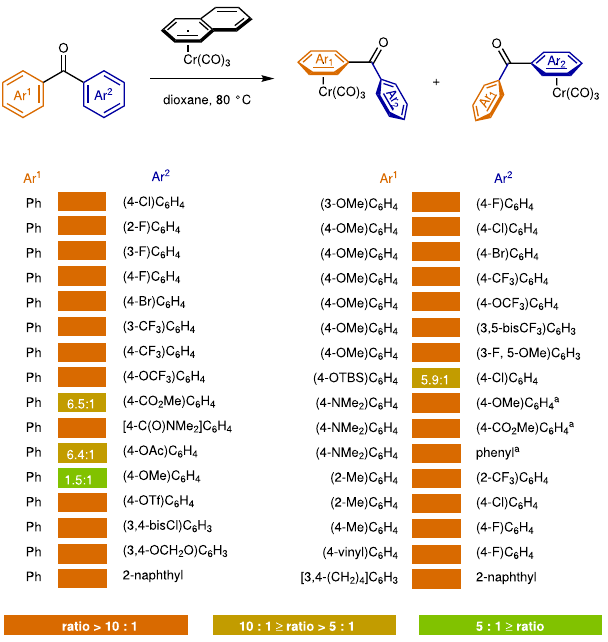
Fig.3|SelectiveformationofCr(CO)3-benzophenonecomplex. Areneexchange reactions between (naphthalene)Cr(CO) 3 ( 2 ) and an array of benzophenones. Reaction conditions, unless otherwise stated: benzophenones (0.10mmol), 2 (0.15mmol), dioxane (1.0mL), N 2 , 80°C, 24h. a 2 (0.11mmol). Ratios were deter- mined by 1 H NMR